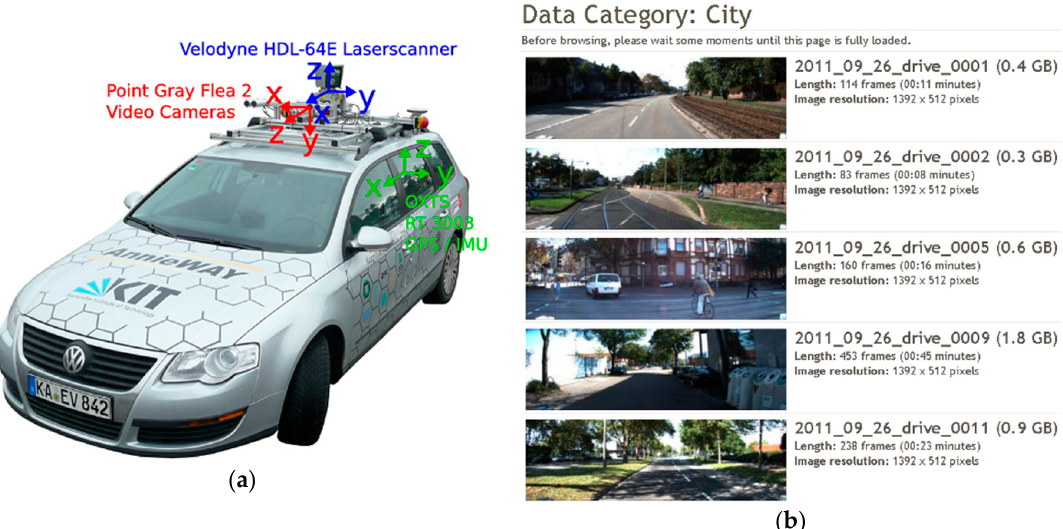
Figure 1. ( a ) Karlsruhe institute of technology and toyota technological institute (KITTI) platform; ( b ) KITTI dataset example [ 16 ].